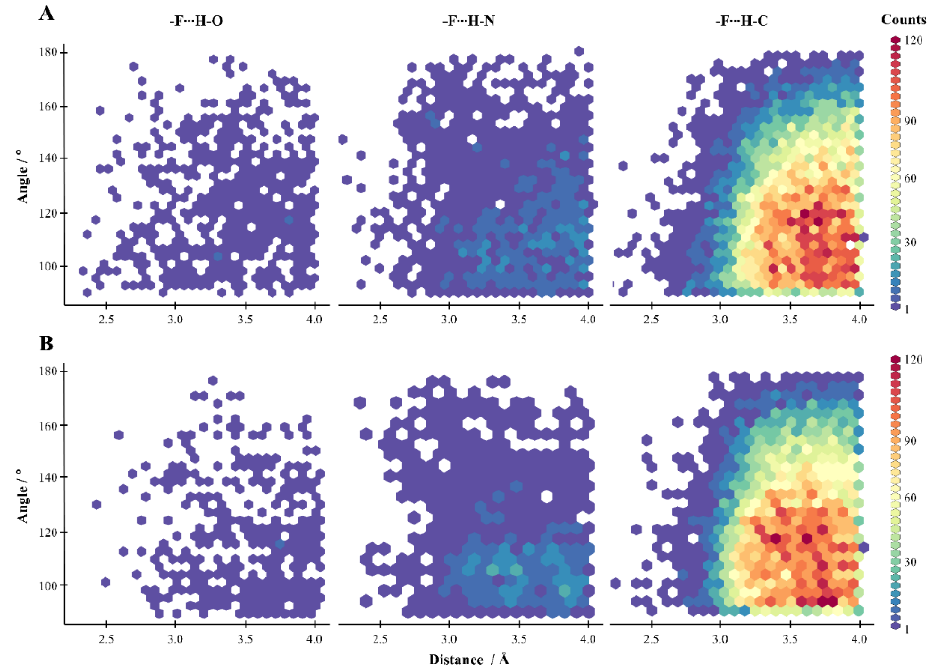
Figure 4. Density maps of geometric parameters of HBs with ( A ) F al and ( B ) F ar .